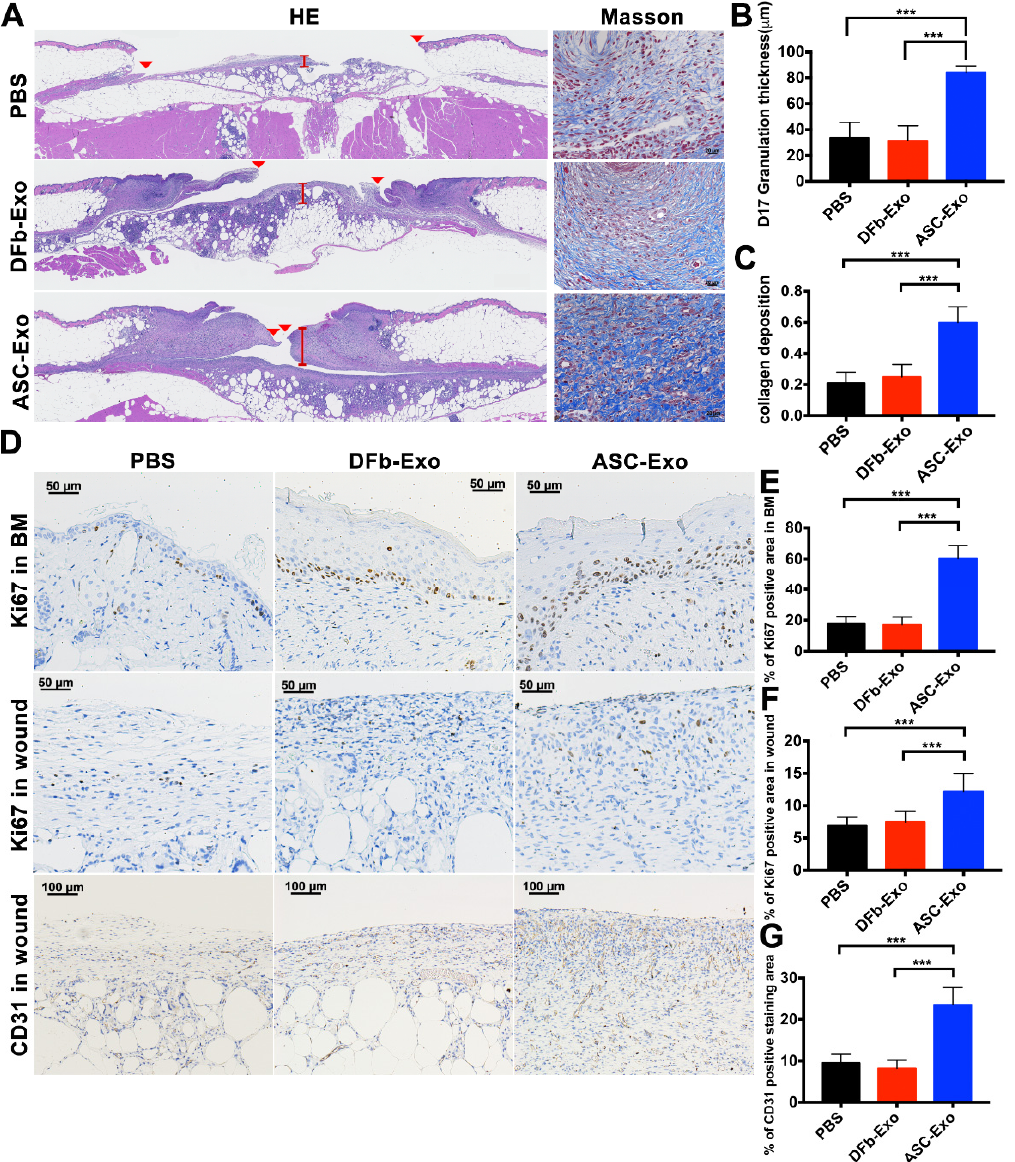
Figure 4. ASC-Exo increases basal keratinocyte and dermal cell proliferation and angiogenesis in wound healing. ( A ) Representative histology on 17 days after wounding for each group. Left panel, hematoxylin and eosin (H&E) stain. The wounds treated with ASC-Exo showed a significantly thicker granulation tissue in comparison with the DFb-Exo and PBS group. Red arrows indicate tips of the healing epithelium tongue. Right panel, Masson’s trichrome stain (scale bar: 1 mm). ( B ) Wound healing tissues were stained for basal keratinocyte and dermal cell proliferation (Ki-67) (upper and central panel, magnification: 200 × ) and vascularity (PECAM-1) (lower panel, magnification: 100 × ). ( C , D ) The wounds treated with ASC-Exo showed a significantly thicker granulation tissue and collage deposition in comparison with the DFb-Exo and PBS group. ( E , F ) The ASC-Exo-treated wounds showed significant increases in basal keratinocytes and dermal cell proliferation when compared with both the DFb-Exo and PBS groups on day 17 (*** p < 0.001). ( G ) The ASC-Exo-treated wounds showed significant increases in calculated blood vessel density when compared with both the DFb-Exo and PBS groups on day 17 (*** p < 0.001). Results represent mean ± SE. Data were analyzed using independent unpaired two-tailed Student’s t -tests ( C – G